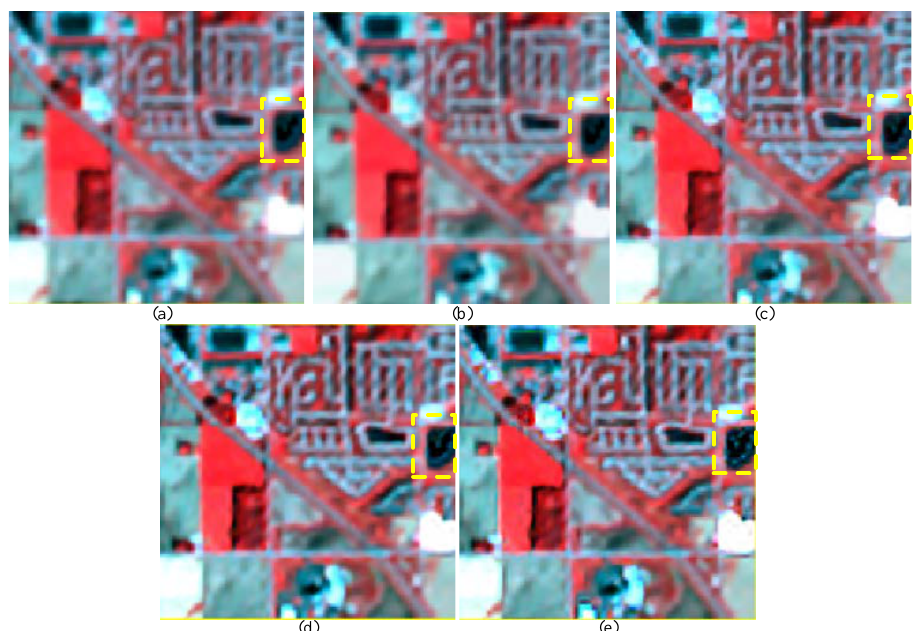
Figure 13. False color composite (band 45, 21, 14) of the enlarged area in the blue box of Figure 12. The size of the area is 200 × 200. ( a ) Result of Bicubic, ( b ) result of SSGS [27], ( c ) result of SRCNN [40], ( d ) result of 3D-CNN [32], and ( e ) result of MW-3D-CNN.